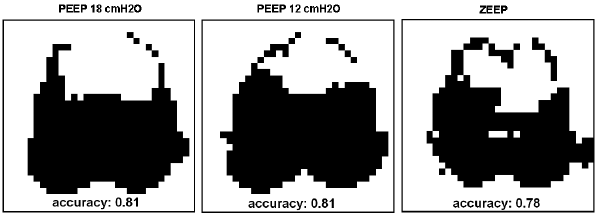
Figure 8 - Total lung maps with respective accuracy indexes obtained from comparison to a sub-sampled 32x32 pixel lung map (figure 7). The maps from left to right correspond to PEEP steps at 18 cm H ZEEP,